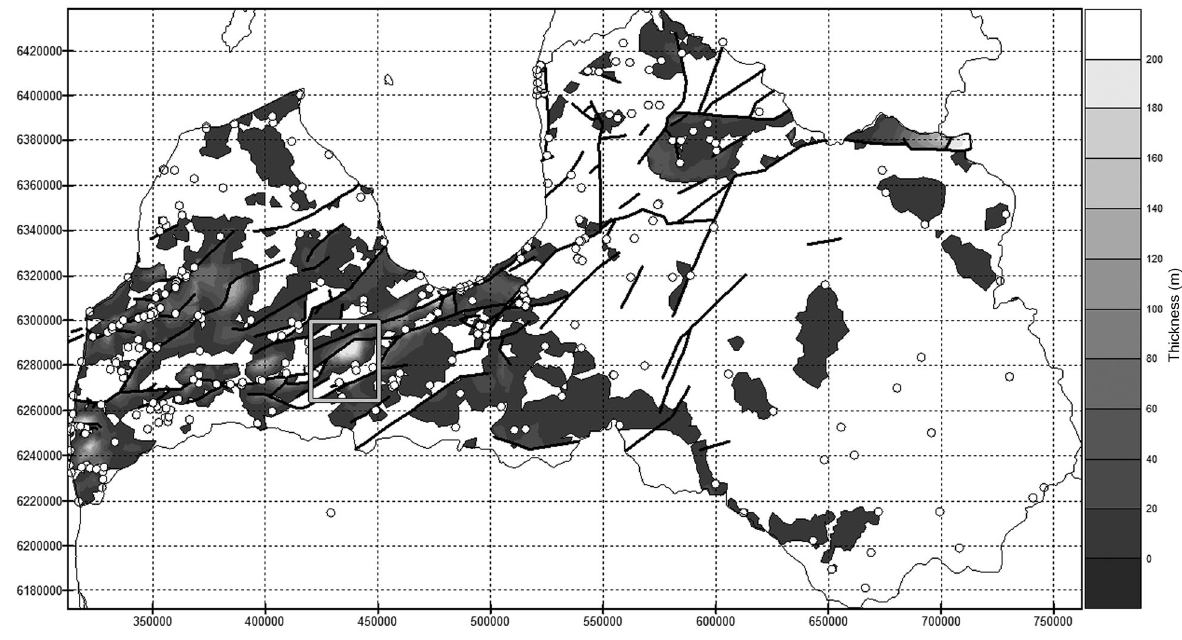
Fig. 5. Thickness offset between the Devonian erosion surface and underlying layers. In blank areas the offset is zero. White dots indicate the boreholes with the Cambrian–Silurian sequence. Black lines – fault lines. The area inside the grey rectangle is zoomed in Fig. 8. Coordinates given in the TM Baltic 93 coordinate system.